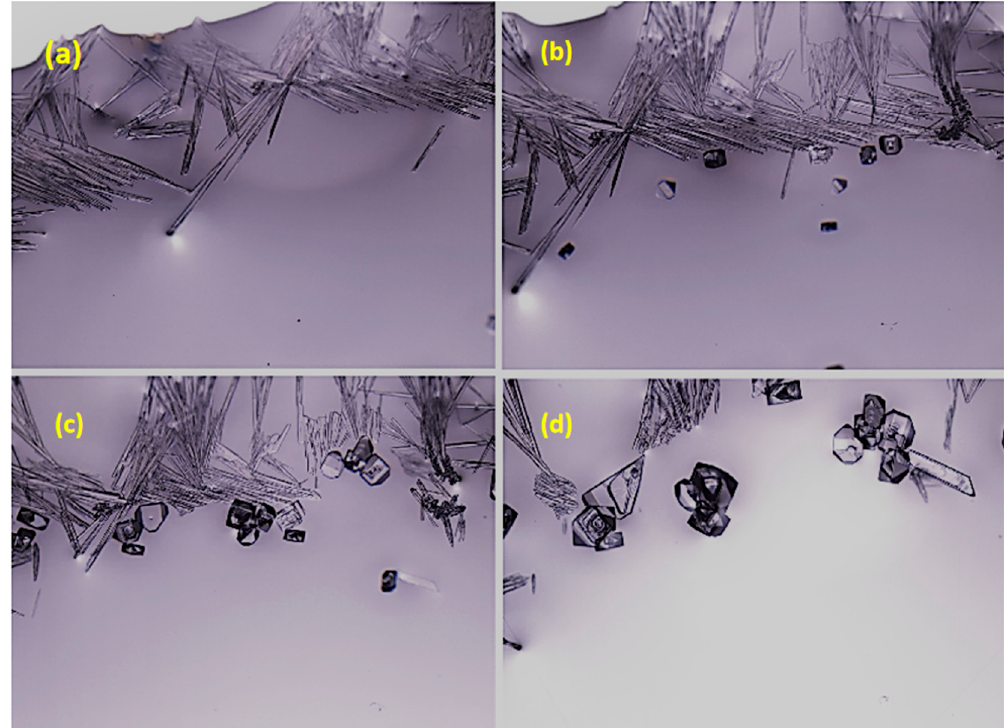
Figure 4. Phase transition of DKDP monoclinic single-crystal fibers as there is tetragonal phase present and growth in the solution. ( a ) the DKDP monoclinic single-crystal fibers growing in a solution droplet on glass substrate. ( b ) the small tetragonal crystal particles appear in the solution. ( c ) the tetragonal crystal particles grow rapidly accompanied by the dissolution of the monoclinic DKDP single-crystalline fibers. ( d ) the tetragonal crystals become large in size and the DKDP single-crystalline fibers disappear